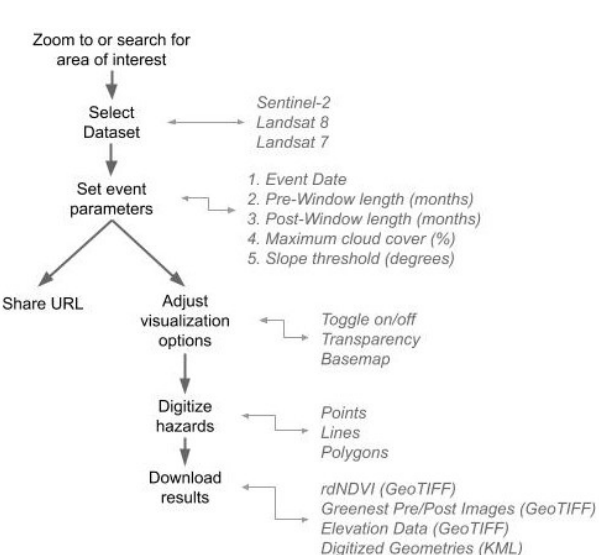
sult, or the “greenest” pixel (Eq.